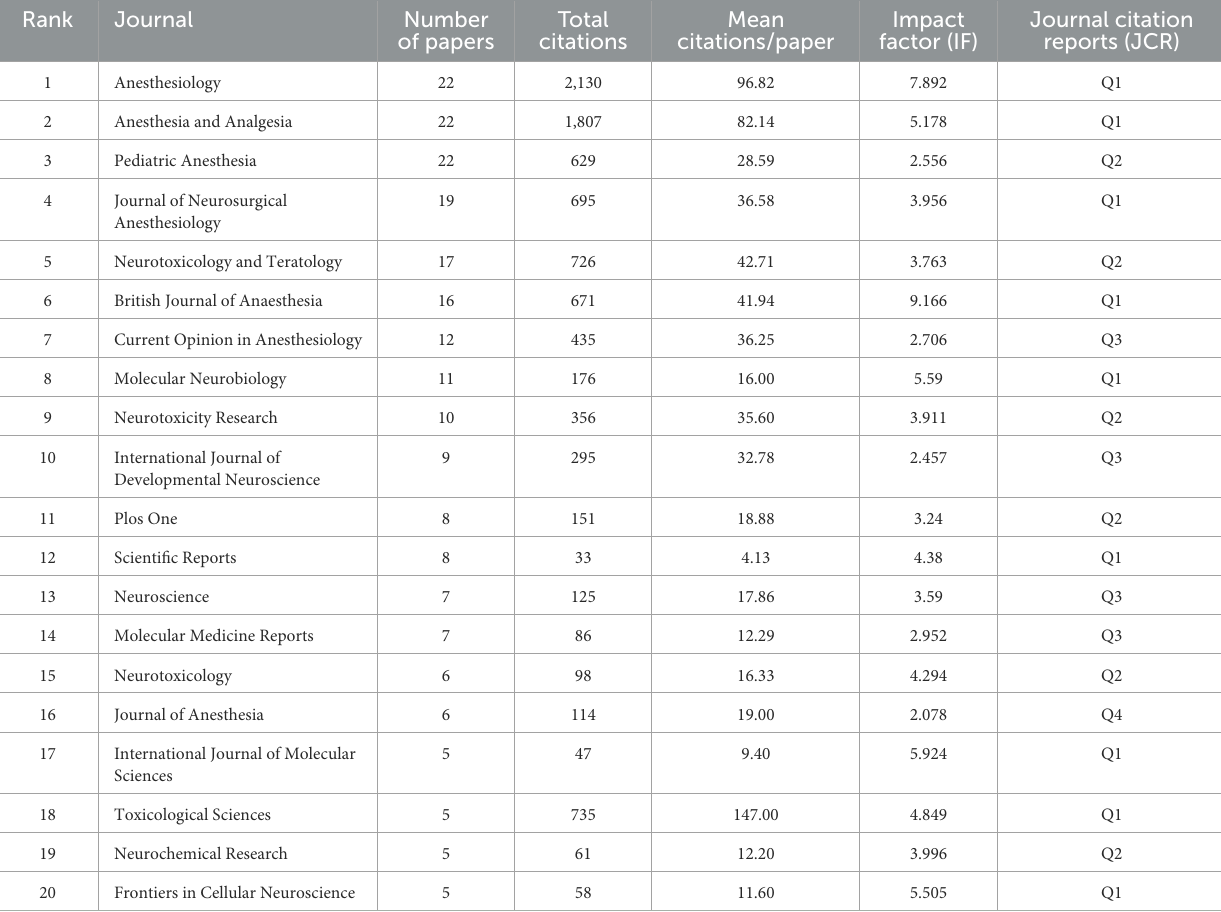
TABLE 4 The top 20 journals with the highest number of publications on the neurotoxicity of anesthesia in the developing brain.